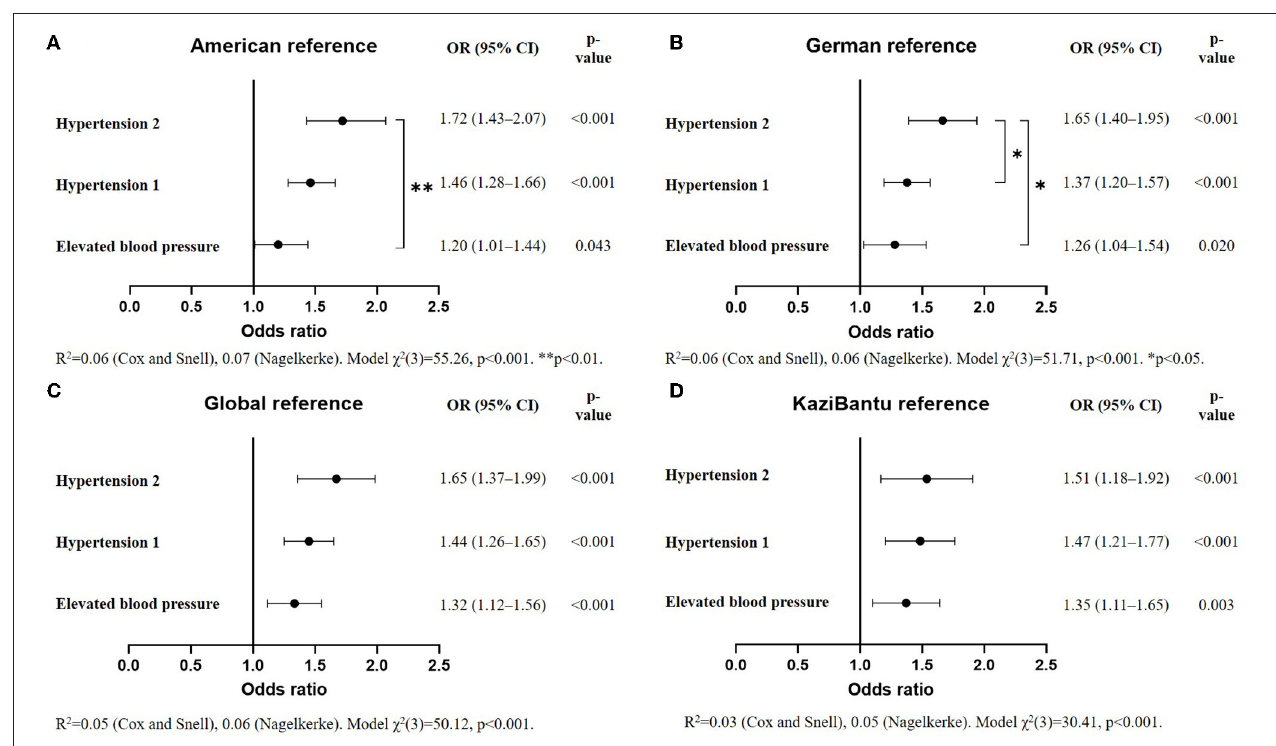
FIGURE 1 | Odds ratio (OR) of the classification of blood pressure (BP) as elevated, hypertension stage 1 or stage 2, relative to normotension, with increasing BMI-for-age Z-scores according to (A) American, (B) German, (C) global, and (D) the KaziBantu reference populations ( N = 897).